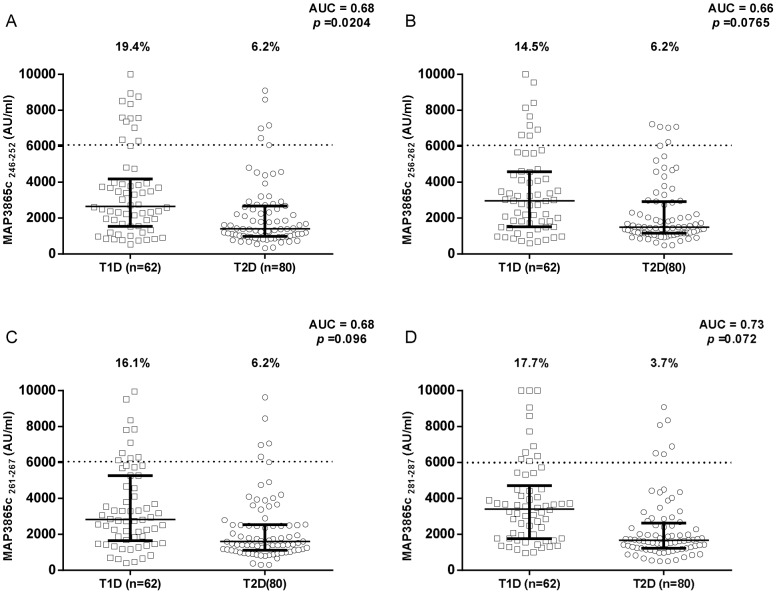
Prevalence of anti-MAP3865c antibodies in T1D and T2D patients with high-risk PDR.Sera were tested for their reactivity against plate-coated MAP3865c246–252 (A), MAP3865c256–262 (B), MAP3865c261–267 (C), and MAP3865c281–287 (D) peptides. Antibody distribution is compared between T1D and T2D patients. Data representation is the same as in Fig. 1.